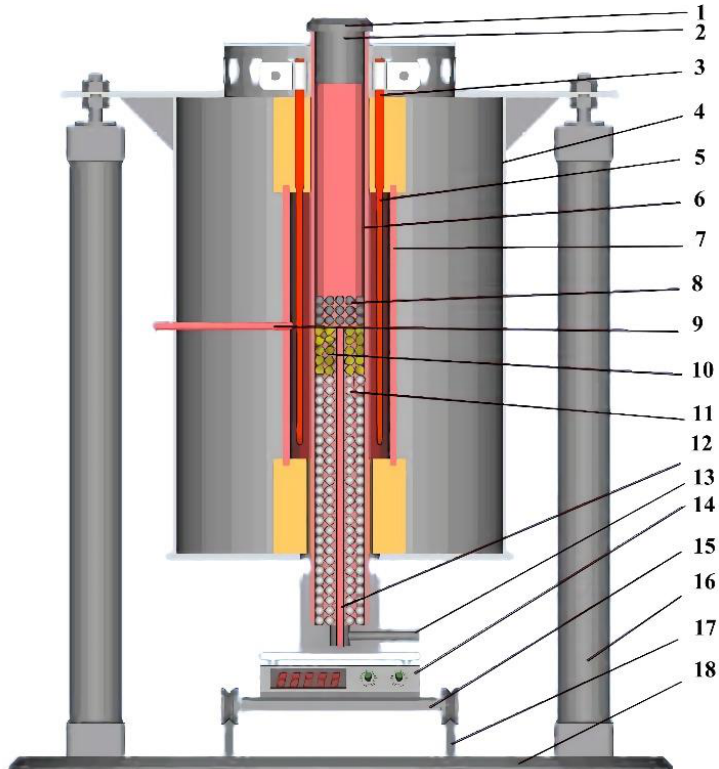
Figure 1. Bracing thermogravimetric device of the gas–solid coupling reaction: 1—gas outlet; 2— sealing cap; 3—silicon molybdenum rod (cold end); 4—furnace shell; 5—silicon molybdenum rod (hot end); 6—reaction tube; 7—outer protective tube; 8—coke samples; 9—thermocouple for temperature control; 10—ore samples; 11—high aluminum ball (refractory); 12—thermocouple for temperature measurement; 13—gas entrance; 14—electronic balance; 15—feeder conveyer; 16—rail way; 17— furnace elevator; 18—bottom plate.